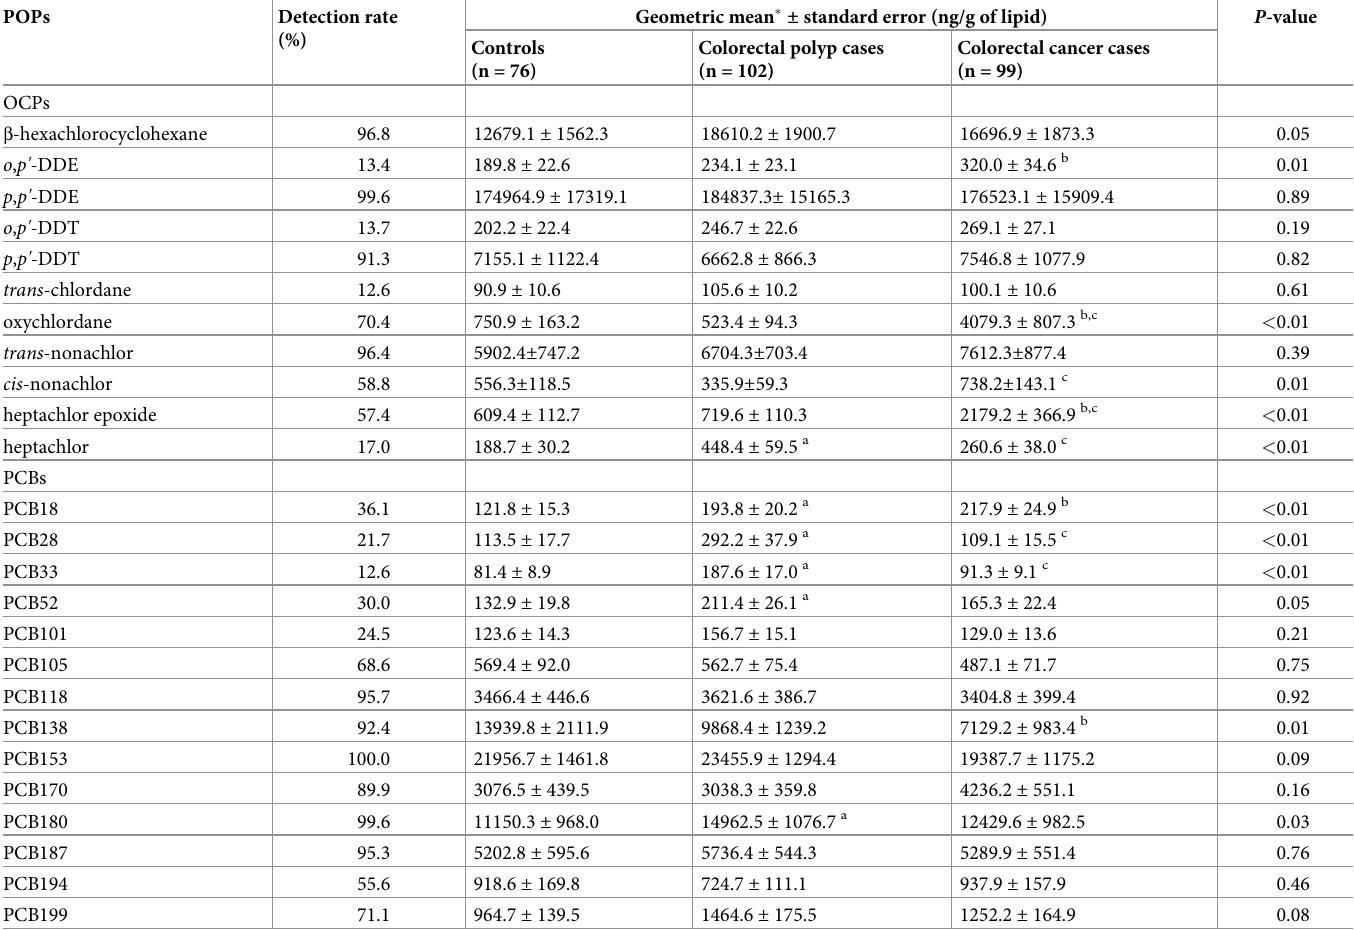
Table 2. Comparison of adjusted geometric means of lipid-adjusted concentrations of organochlorine pesticides and polychlorinated biphenyls among the control, colorectal polyp, and colorectal cancer groups.